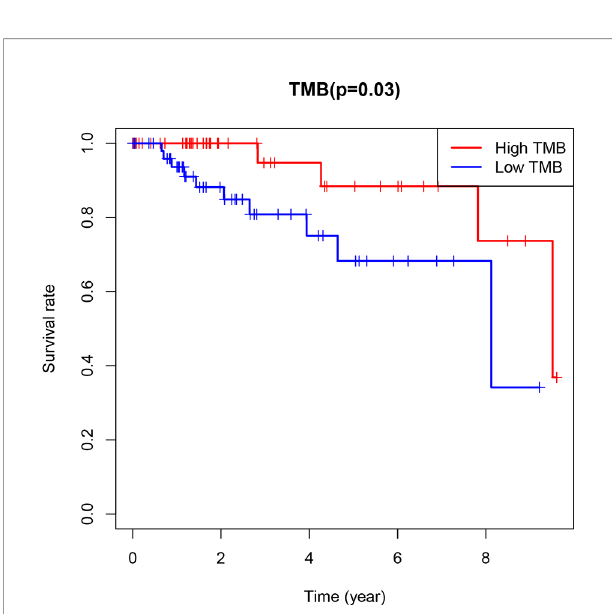
FIGURE 2 | Kaplan-Meier survival analysis with R package was used to analyze the survival of high and low TMB groups